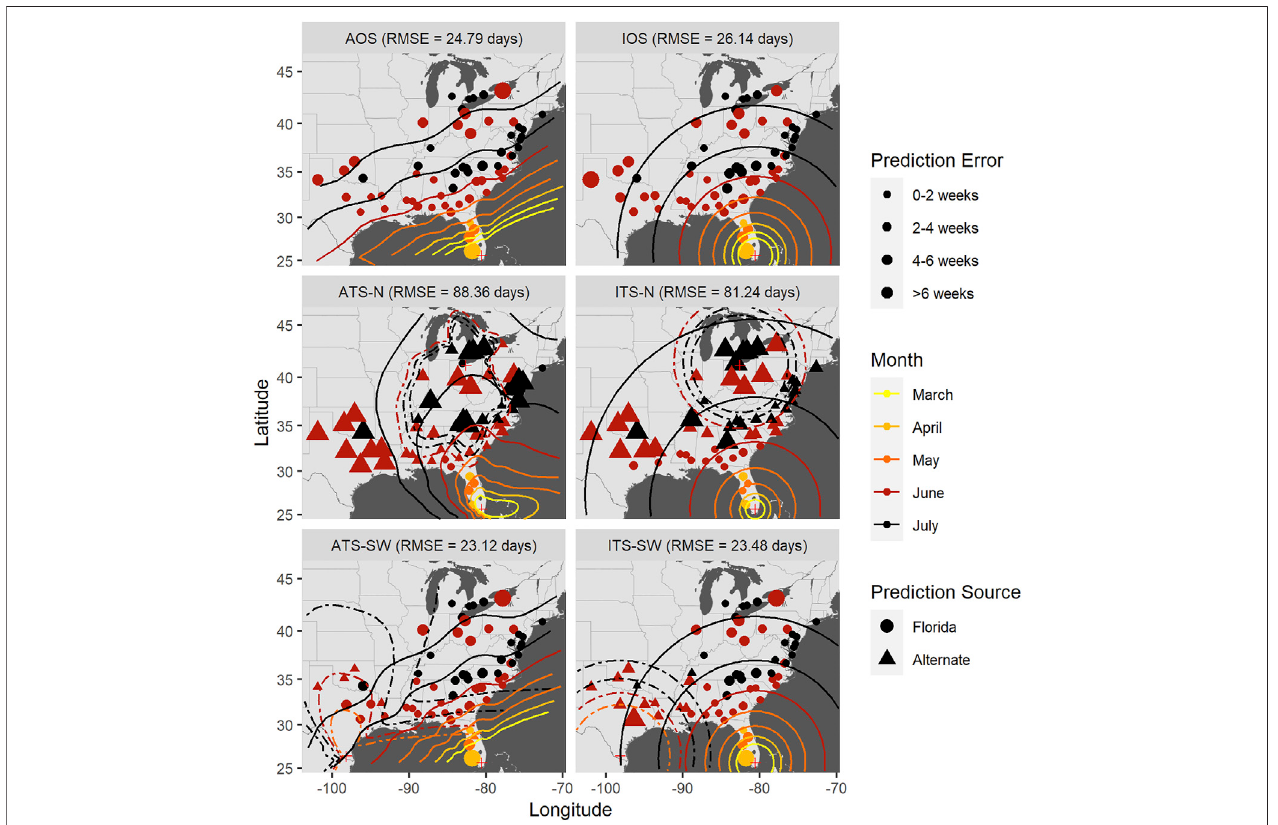
FIGURE8| Time-of-occurrencepredictionerrorsforpredictionsfrom isotropicandanisotropicone-andtwo-sourcemodels fi ttodatafromsentinel plotsin2009, withcontoursrepresentingestimateddiseasefrontovertimeaccordingtothemodels.Thetwo-sourcemodelswereeach fi twithtwoalternate(non-FL)sourcelocations: anorthernandasouthwesternlocation.Eachpanelshowsresultsaccordingtoadifferentmodel:isotropicone-source(IOS);isotropictwo-source(ITS);anisotropicone- source (AOS); and anisotropic two-source (ATS).